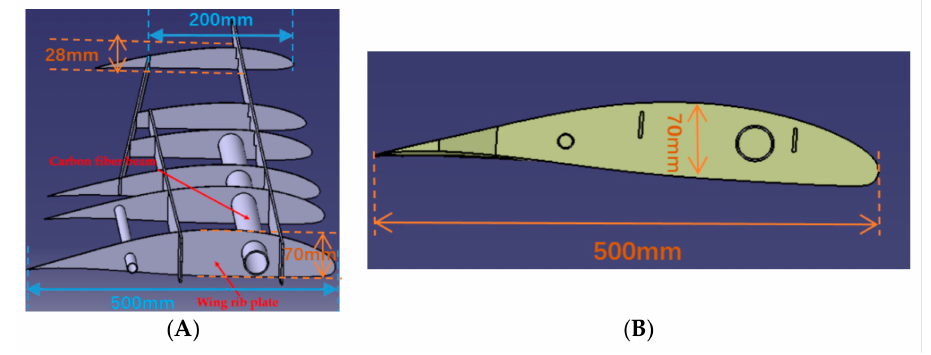
Figure 10. Wing structure. ( A ) Framework of the wing; ( B ) wing cross